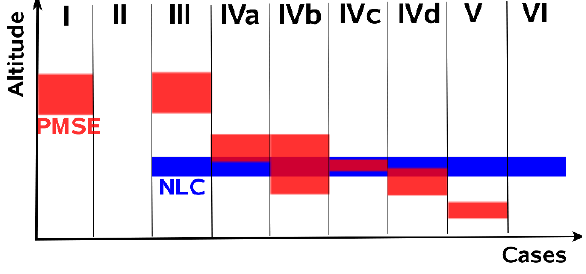
Fig. 3. Schematic drawing of cases of PMSE and NLC occurrence. They are distinguished by the occurrence and relative top and bot- tom altitudes.